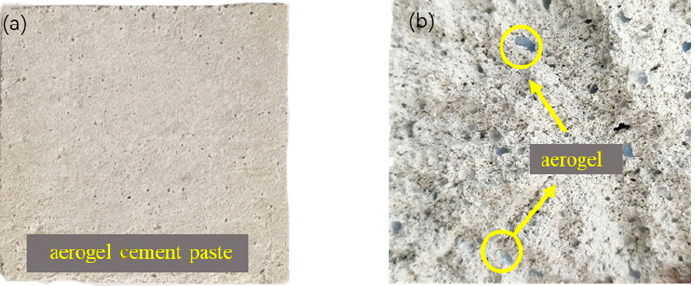
Figure 5. The ACP morphology before the simulated tunnel fire: ( a ) surface morphology; ( b ) section morphology.